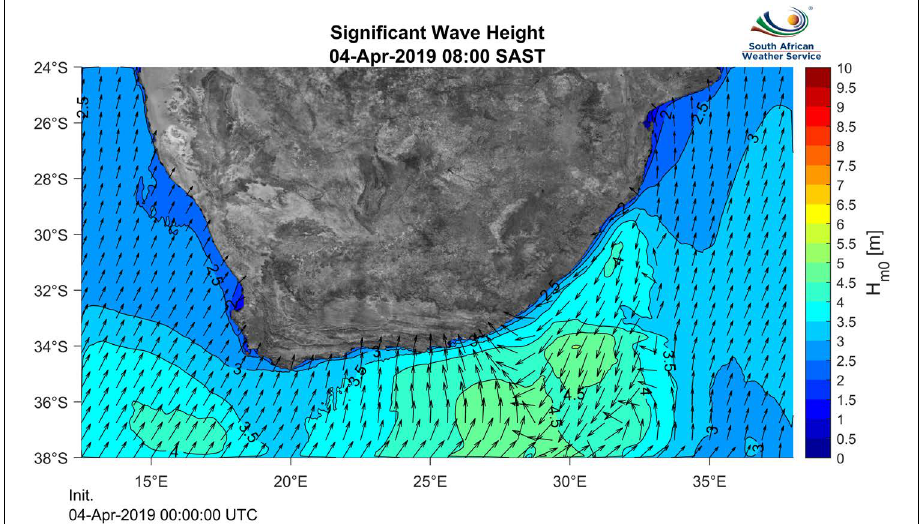
Figure 1: Significant wave height forecast for the entire coast of South